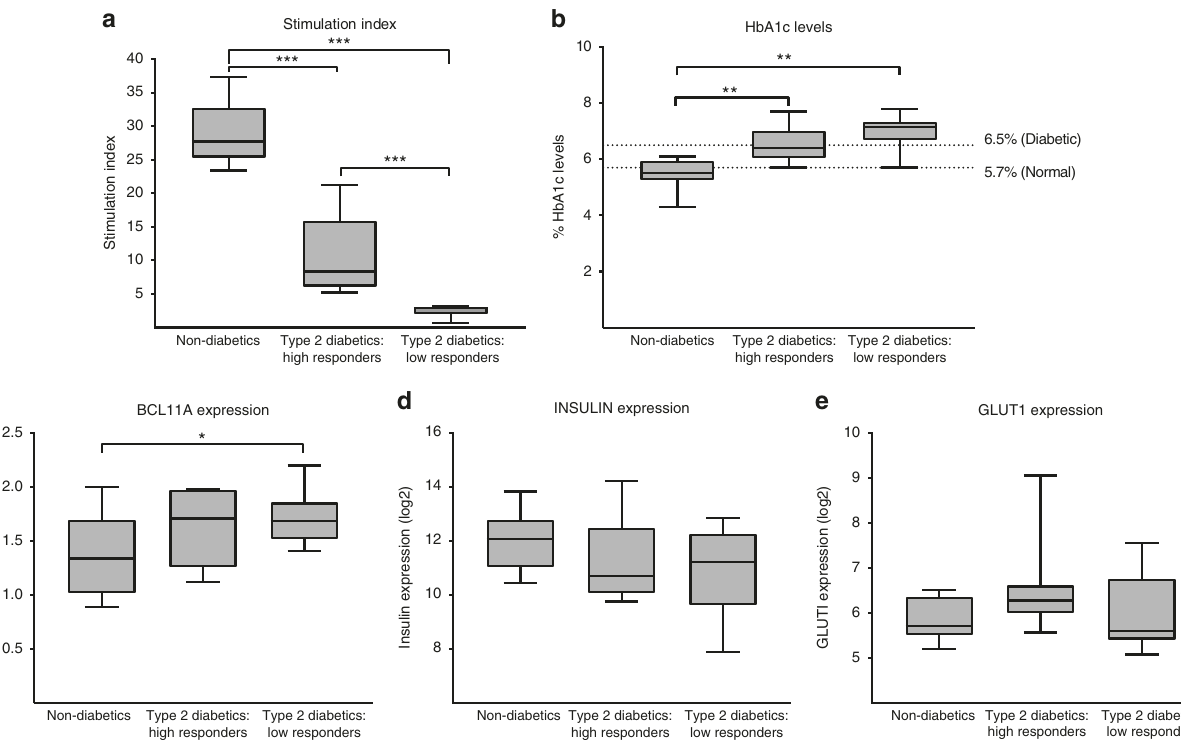
Fig. 2 Gene expression changes in T2D human islets. a Stimulation index of isolated human islets in response to glucose among the three de fi ned groups. b Donor Hba1c levels among the three groups, dotted lines indicate the levels of normal (below 5.7%), pre-diabetic (5.7 – 6.5%) and diabetic (above 6.5%) individuals. c BCL11A mRNA expression across the three groups. d INSULIN mRNA expression across the three groups. e GLUT1 mRNA expression across the three groups. See also Supplementary Figure 2. The data obtained from a total of 30 donors (10 per group), presented as boxplots, center line represents the mean, whiskers represent the minimum and maximum points, and two-tailed t tests were used to generate p values. * p < 0.05, ** p < 0.01, *** p <